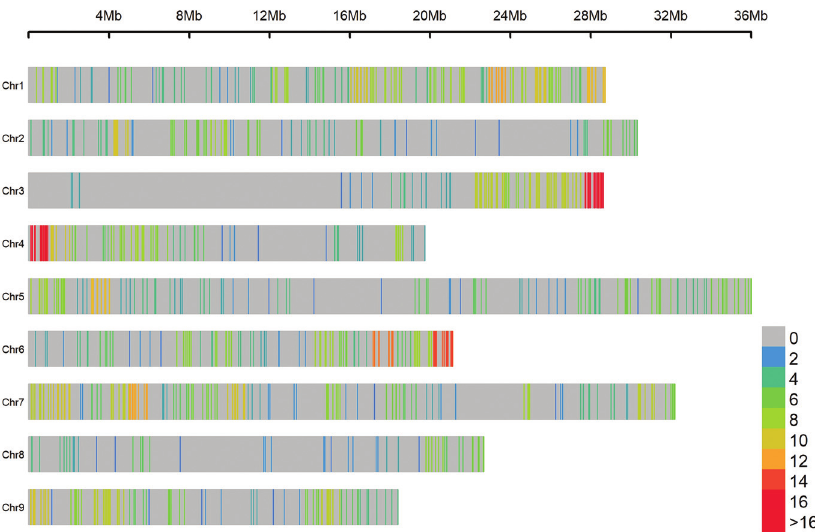
Figure 2 - Density of markers in the chromosomes after considering a call rate < 90, missing calls in the parent genotyping for C. sunki and P. trifoliata and distortion segregation.